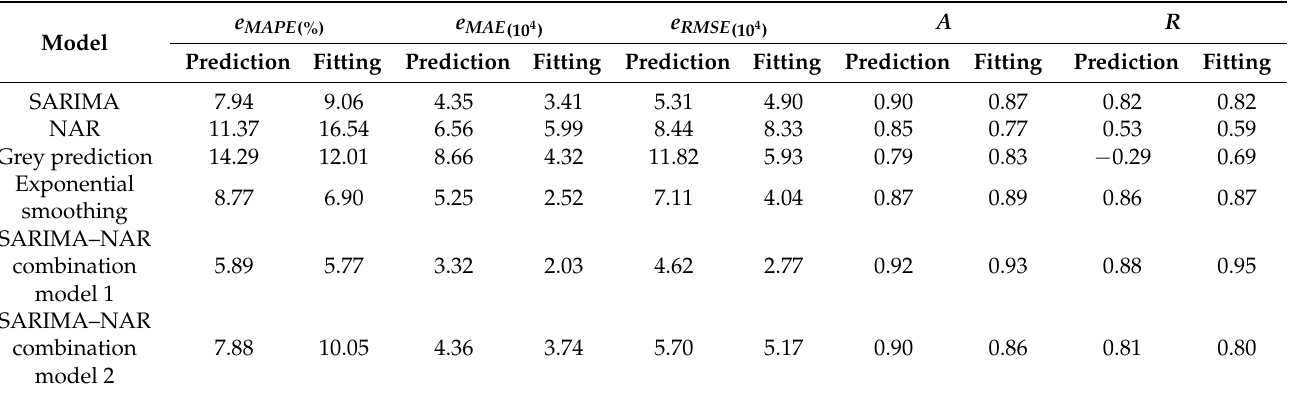
Table 4. Statistics of traffic forecast